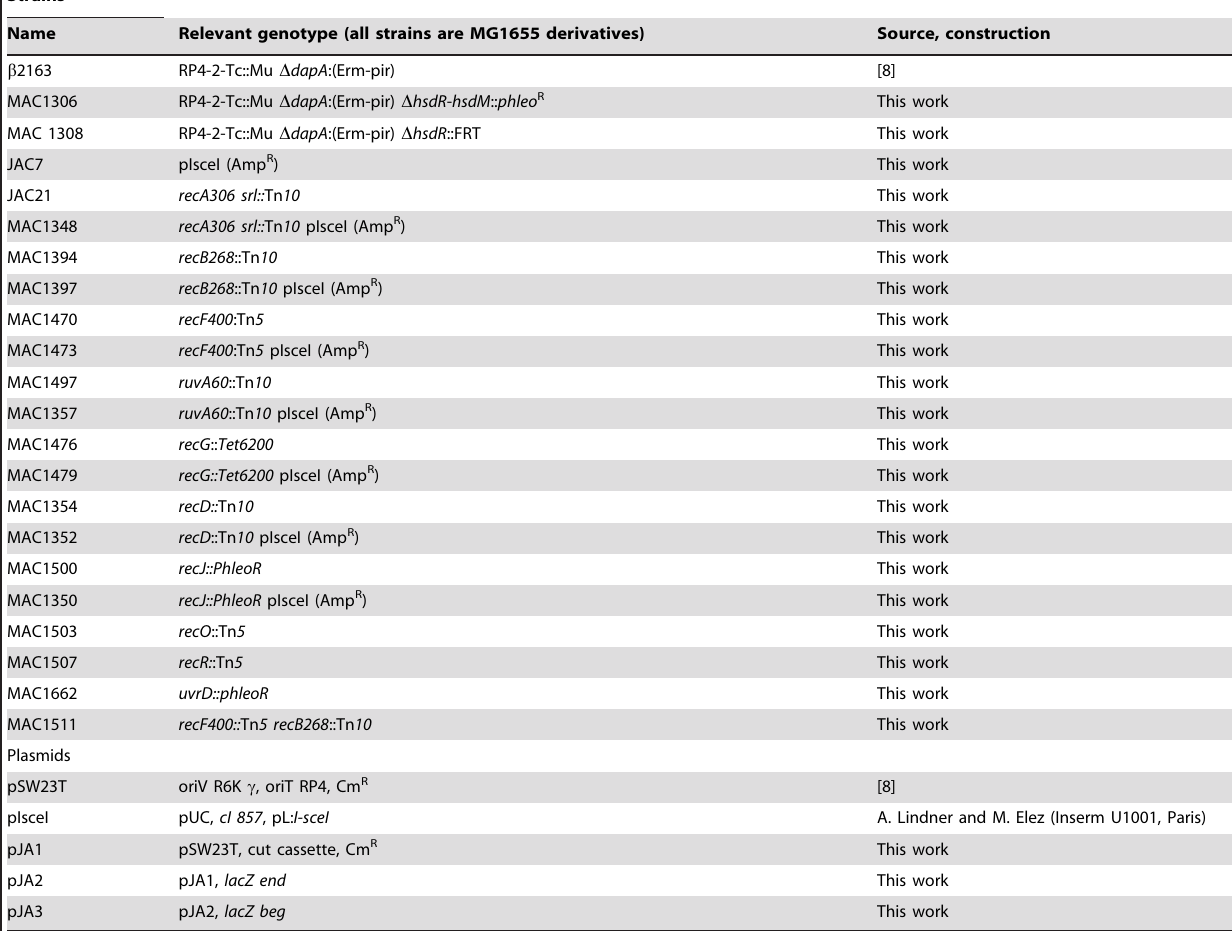
Strains Name Relevant genotype (all strains are MG1655 derivatives) Source,